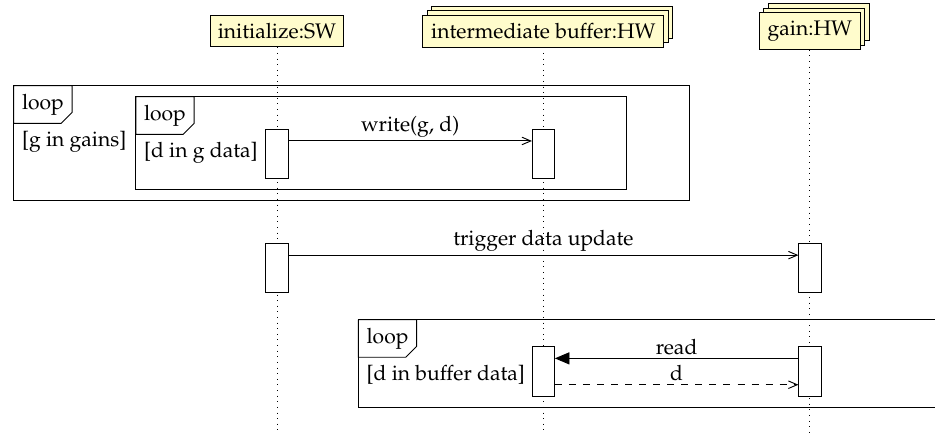
Figure 9. UML sequence diagram demonstrating the concept of (re)initialization of gain data The starting and stopping use cases are both based on the manipulation of the 218 same flag to enable feedback data propagation to the regulation algorithm. This one-bit 219